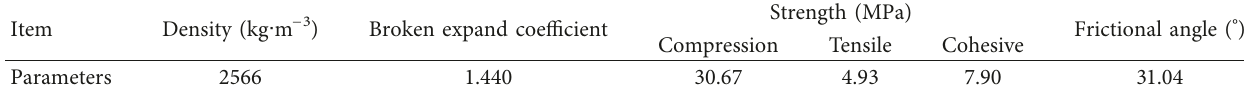
Figure 3: SEM images at different resolutions in the main roof: (a) 100X; (b) 250X; (c) 350X; (d) 500X; (e) 800X; (f) 1000X. Table 1: Physical and mechanical parameters of extra-thick sandstone roof.